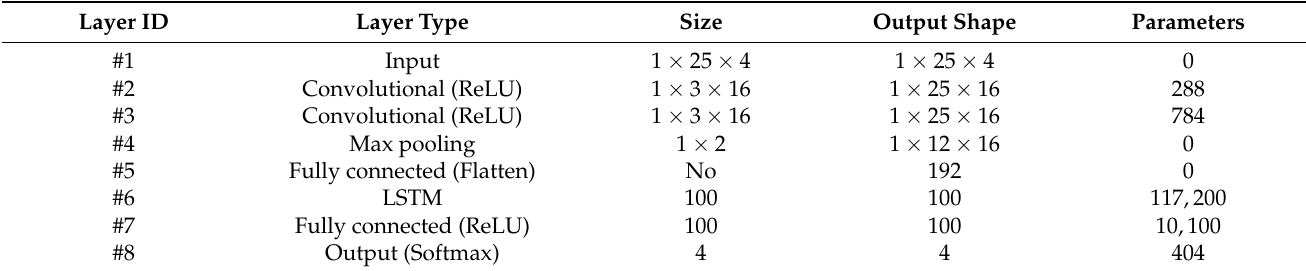
Table 2. Layer configuration of CLSTM neural network model.